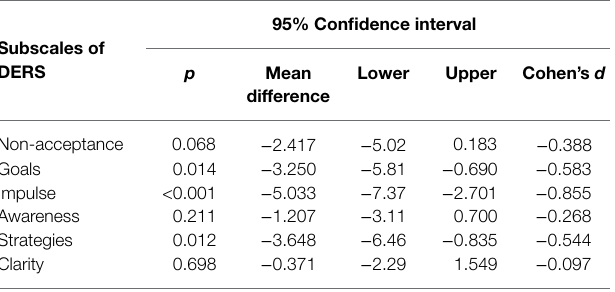
TABLE 2 | Levels of emotion dysregulation in relation to self-harm in forensic psychiatric patients ( n = 88) * .